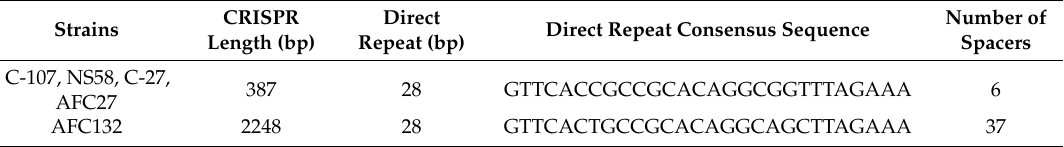
Table 3. Comparison of the CRISPR elements in Nitrosococcus oceani